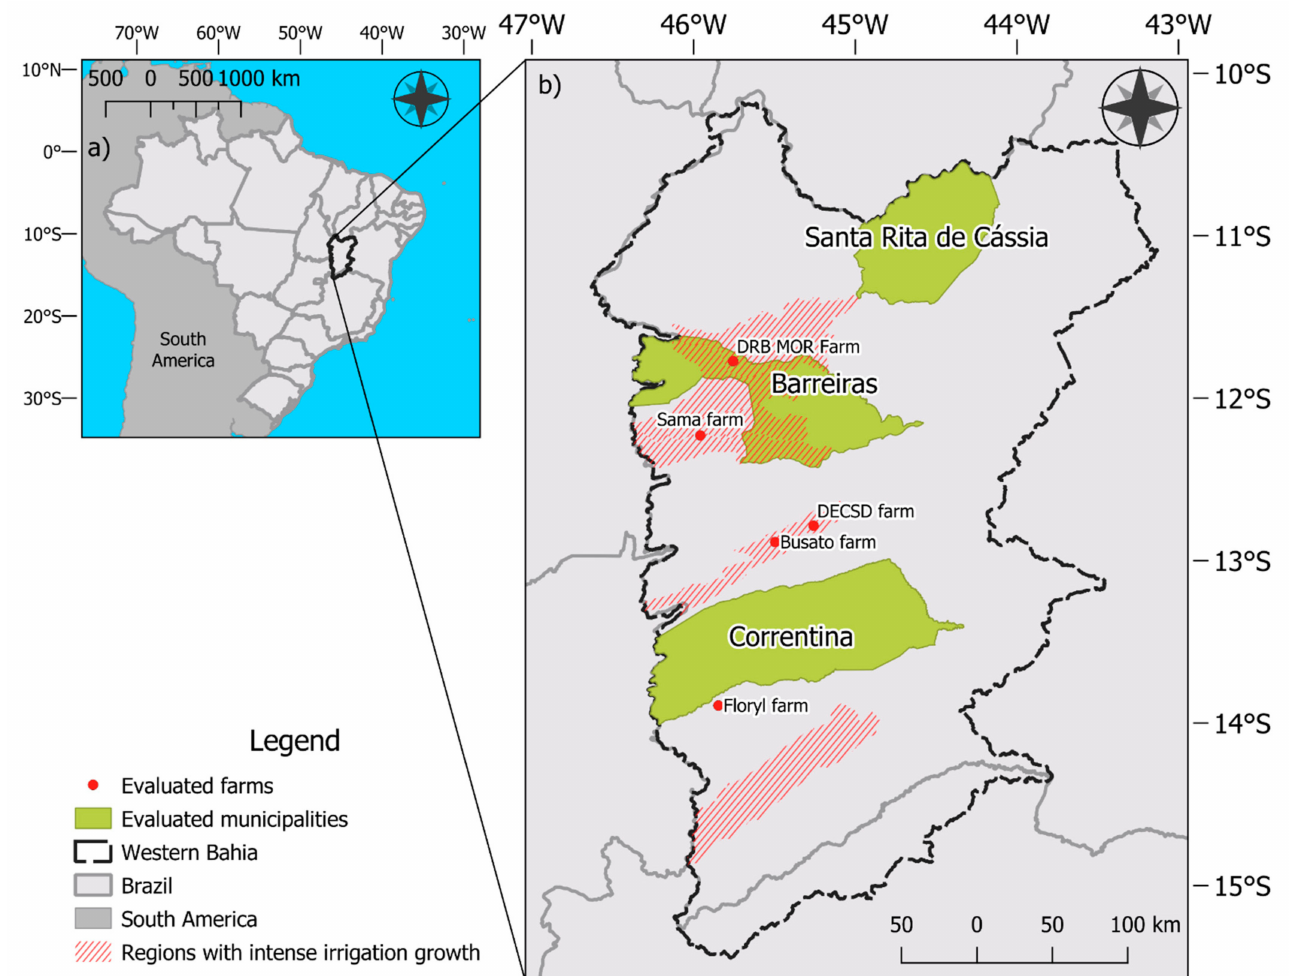
Figure 2. General view of Western Bahia region. ( a ) This region is defined by the union of basins of the Grande, Corrente, and Carinhanha Rivers. Part of the Carinhanha River basin is over the territory of Minas Gerais State. ( b ) Location of farms and municipalities where the linear programming model was applied in case studies (characterized in Section 3.1). Red dots represent the farms’ locations. Green areas correspond to municipal areas. Red lines pattern fill represent areas more susceptible to the water crisis in Western Bahia, evaluated by Pousa et al.